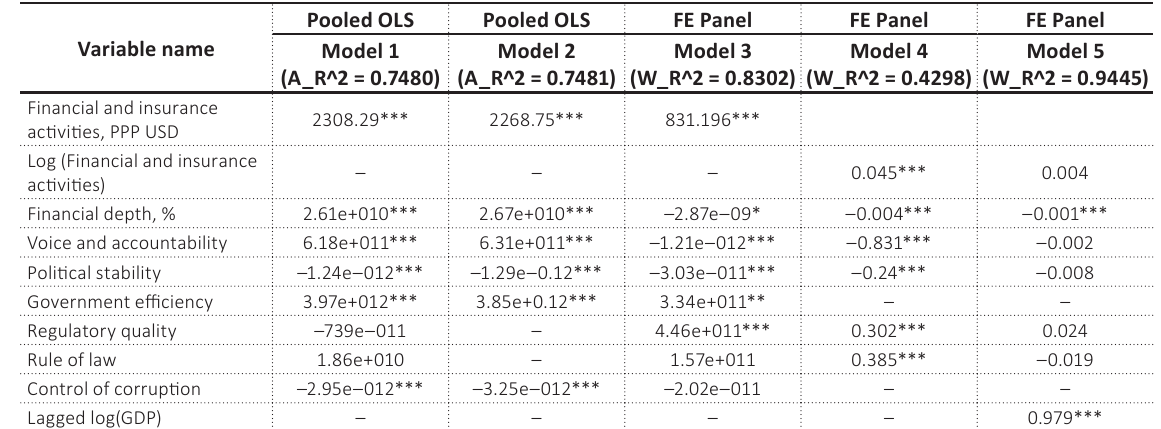
Table 3. Test models variables’